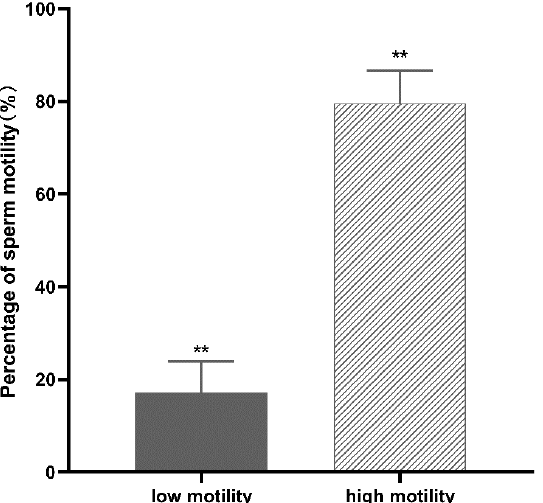
Figure 1. Comparison of the percentages of motile spermatozoa in normal and poorly motile sperm samples. ** p < 0.01.